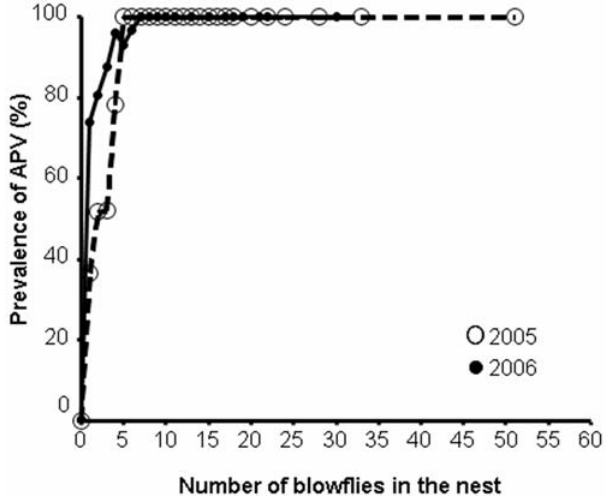
Figure 3. Intensities of infection by APV in nestlings and adult birds. Shown are mean 6 SD scores quantifying the number of viral gene copies as assessed by RT-PCR Mann-Whitney U-tests give highly significant differences ( P , 0.001) for all possible between-group comparisons in both years. Numbers above bars are sample sizes (numbers of